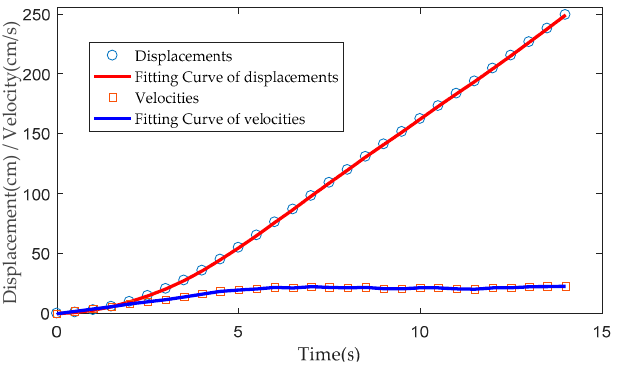
Figure 22. Underwater forward motion on the water surface.